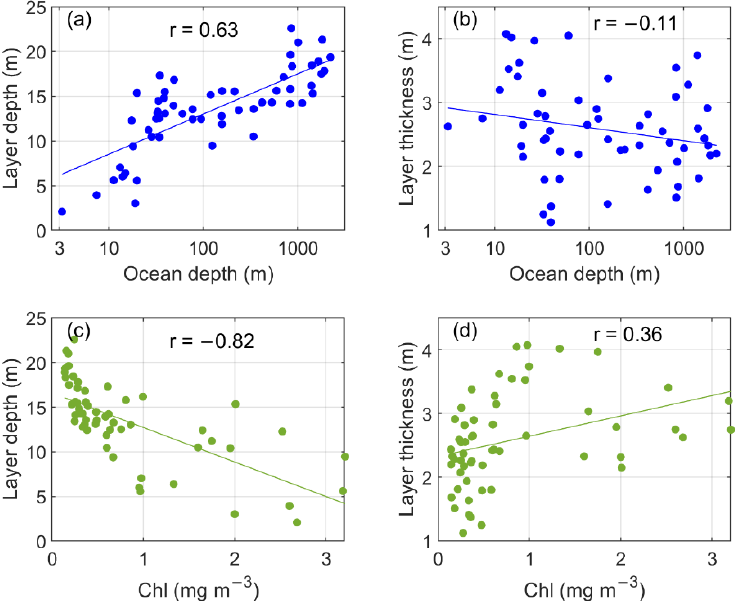
Figure 10. Statistical analysis of ( a ) layer depth vs. ocean depth; ( b ) layer thickness vs. ocean depth; ( c ) layer depth vs. chlorophyll concentration; ( d ) layer thickness vs. chlorophyll concentration.